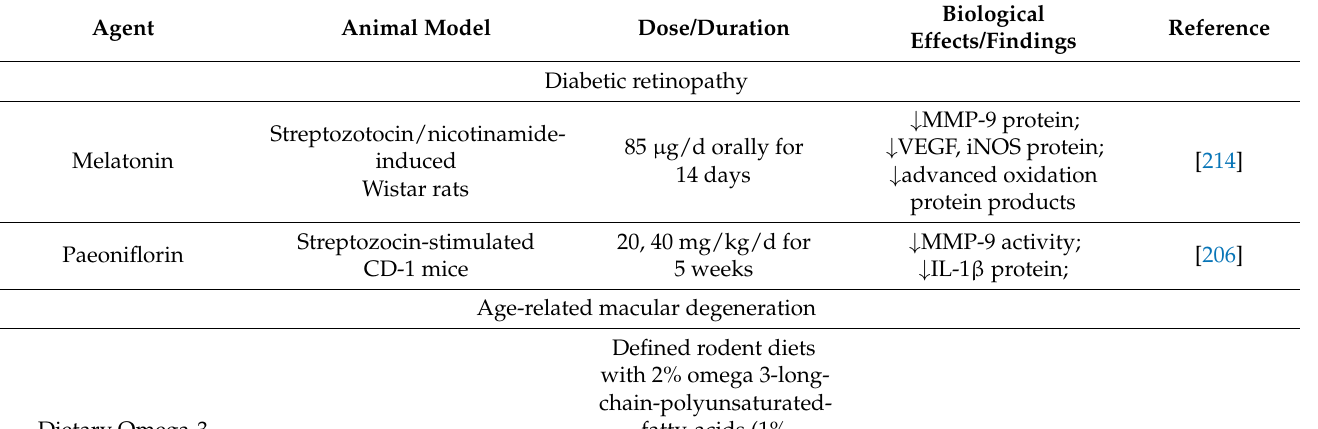
Table 2. Overview of in vivo studies associated with the modulation of MMPs and TIMPs in eye